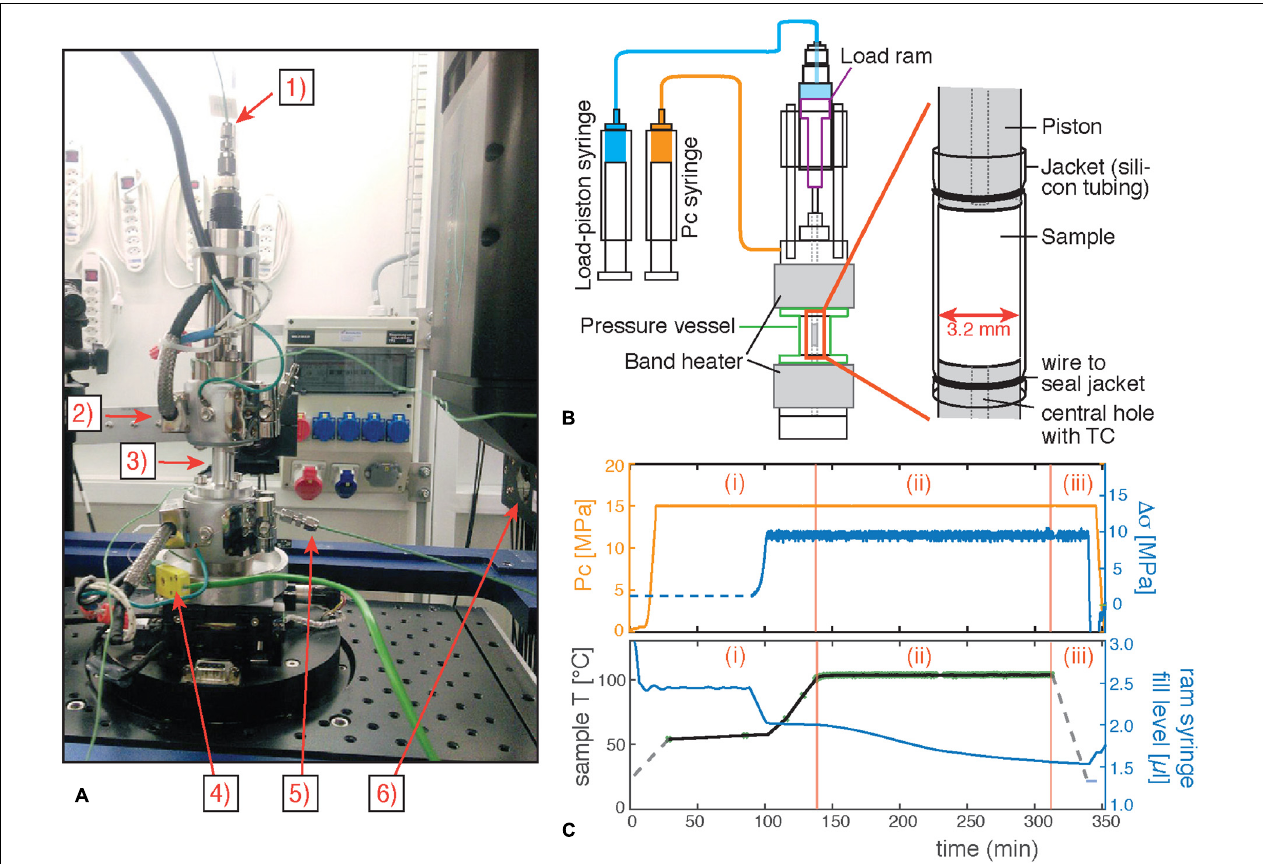
FIGURE 5 | Experimental setup. (A) Photograph of the deformation rig Mjölnir installed at the TOMCAT beamline. (1) Fluid inlet to load ram. (2) Upper band heater. (3) X-ray transparent pressure vessel (sample located inside). (4) Thermocouple connector. (5) Confining fluid inlet. (6) Scintillator. (B) Schematic sketch of Mjölnir , the high-pressure syringes controlling load and confining pressure, and the inner sample assembly. (C) Data derived from high-pressure pumps and temperature log. Stages of an experiment are indicated: (i) Initiation of the experiment: Pressurization, loading and heating (ii) Main part of the experiment with XTM scans at short intervals. Semi-transparent green crosses on temperature log curve (black) indicate time of XTM scan acquisition. (iii) End of experiment. De-pressurization and cooling. The ram syringe fill level curve is a proxy for load piston displacement. Decrease of the syringe fill level during the experiment indicates advance of the piston into the sample chamber as response to sample